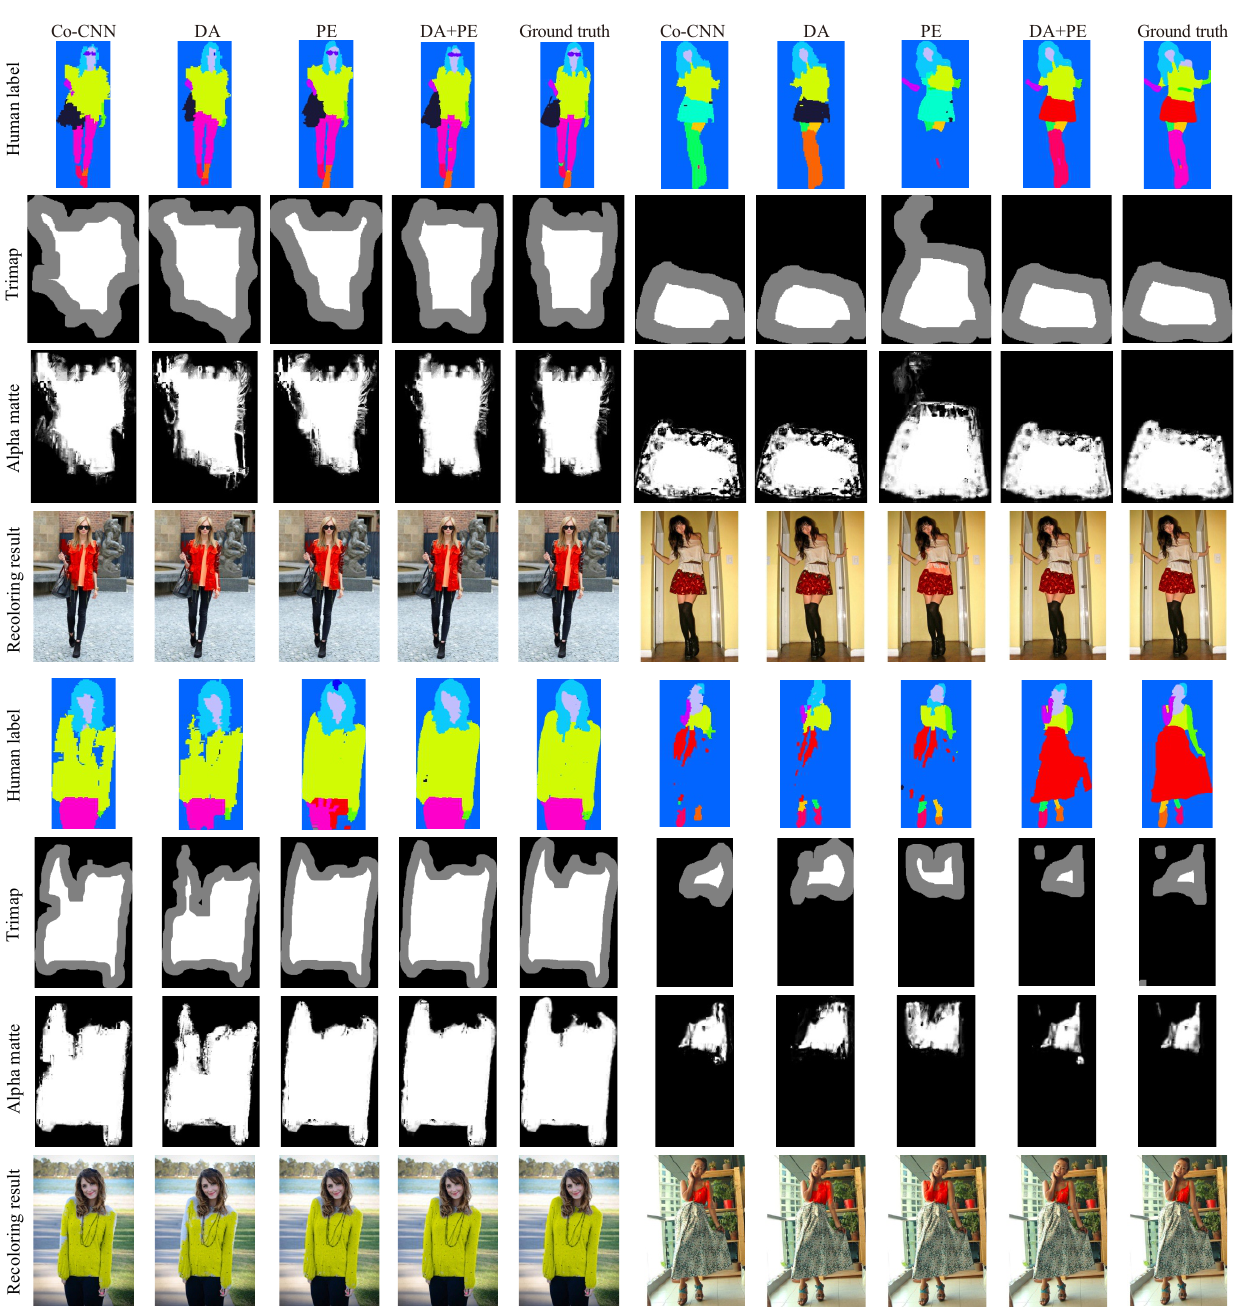
Fig. 5 Garment recoloring. To refine each extracted garment region, we generate a trimap using morphological operations and apply alpha matting. We then change the color of the region by replacing ab channels in Lab color space with a user-specified color. We also apply boundary smoothing as post processing. The input images are shown in the first two rows of Fig. 4. automatically change the colors in specific garment